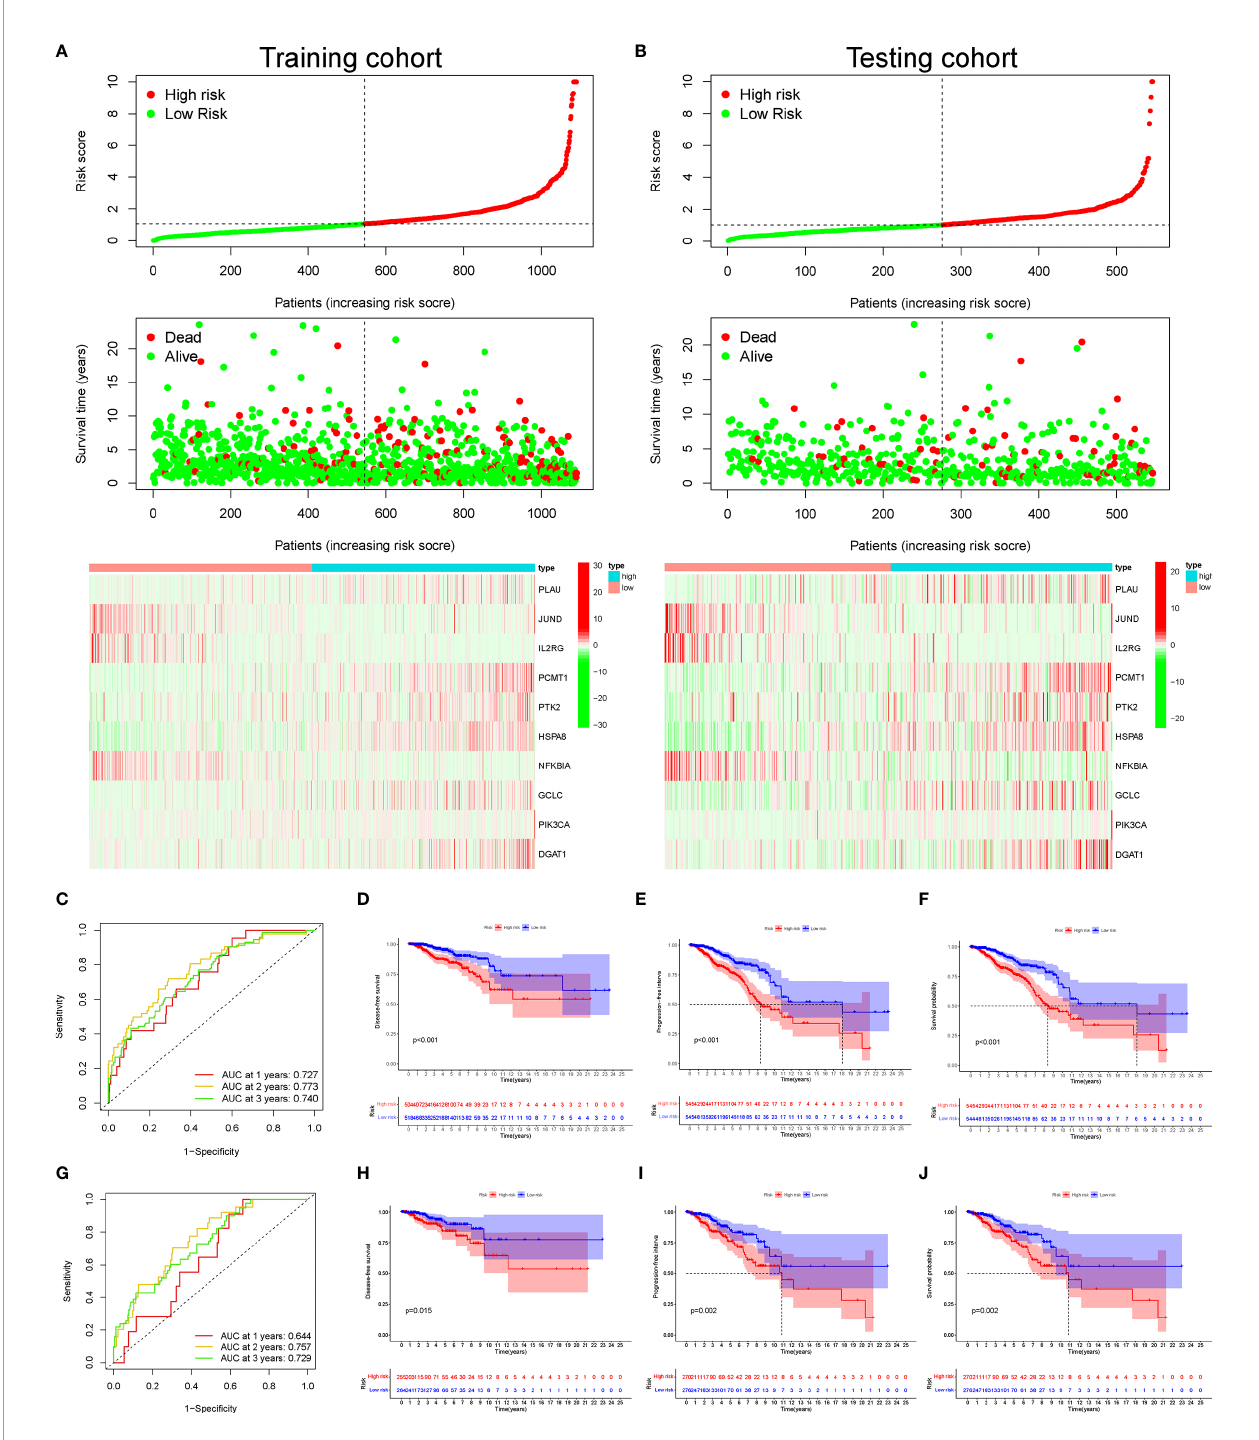
FIGURE 3 | The distribution of risk score, survival status, and heatmap of mRNA expression panel. The time-dependent receiver operating characteristic (ROC) curve analysis and Kaplan – Meier curve of the 10 aging-related gene (AG) signature in The Cancer Genome Atlas (TCGA) datasets. The distribution of risk score, survival status, and the 10 AG expression panel of breast cancer (BC) patients with different risk scores in the training cohort (A) and testing cohort (B) . The green and red dots represented survival and death, respectively. Time-dependent ROC curve analysis in the training cohort (C) and testing cohort (G) . The Kaplan – Meier survival analysis showing the disease-free survival (DFS), progression-free interval (PFI), and the overall survival (OS) of BC patients between high- and low-risk groups in the training cohort (D – F) and testing cohort (H – J)